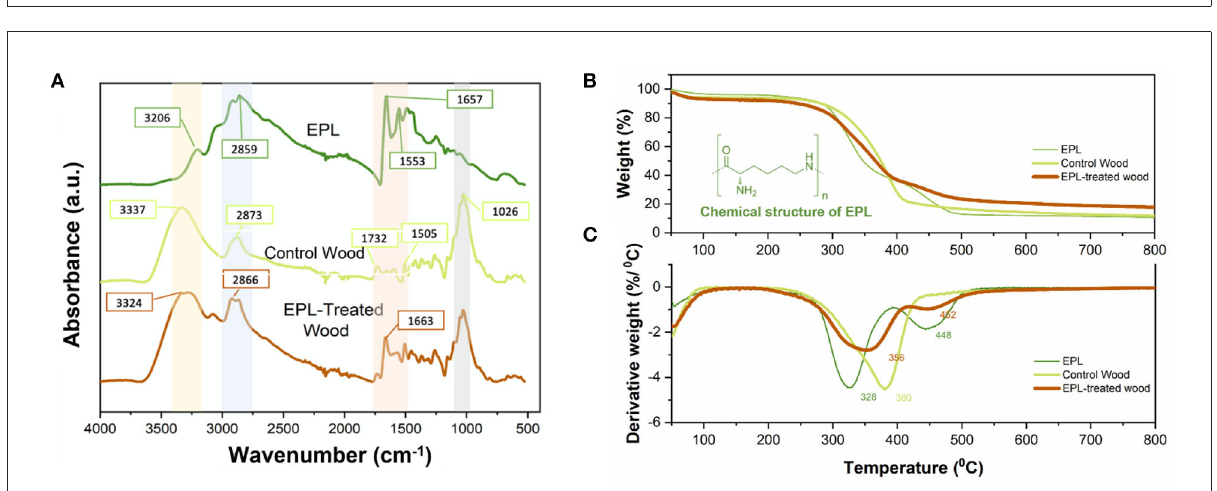
FIGURE4 (A) Infrared spectra, (B) thermal gravimetric (TG) analysis, and (C) derivative TG of EPL, control, and EPL-treated wood